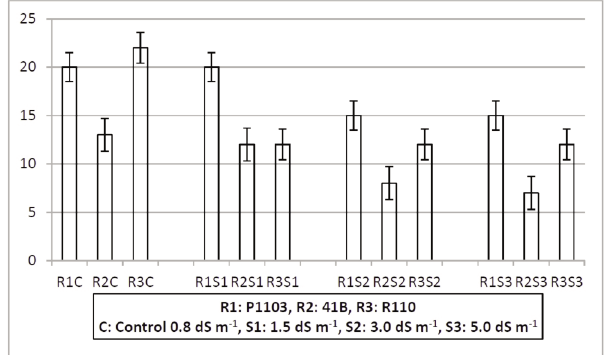
Fig. 5 - The effect of the salinity level treatments on the total number of leaves per grapevine counted in April of the following year for the three